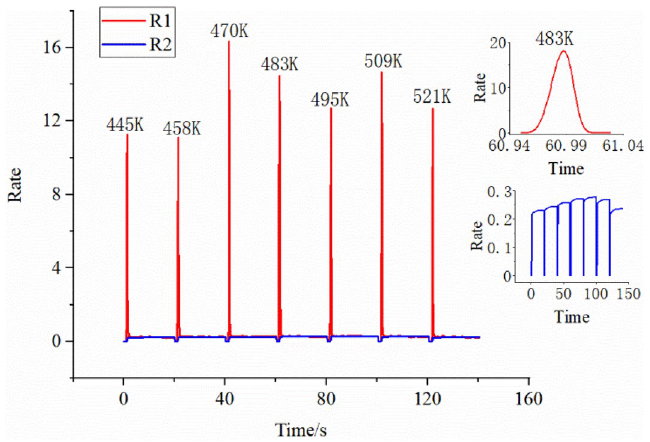
Figure 7. Rate of chemical reaction that generates (R1) and consumes (R2) oxygen ions. The red inset curve is a zoomed-in view of the chemical reaction rate of oxygen ion generation at a temperature of 483 K. The blue inset curve is a zoomed-in view of the chemical reaction rate of oxygen ion consumption at different temperatures.